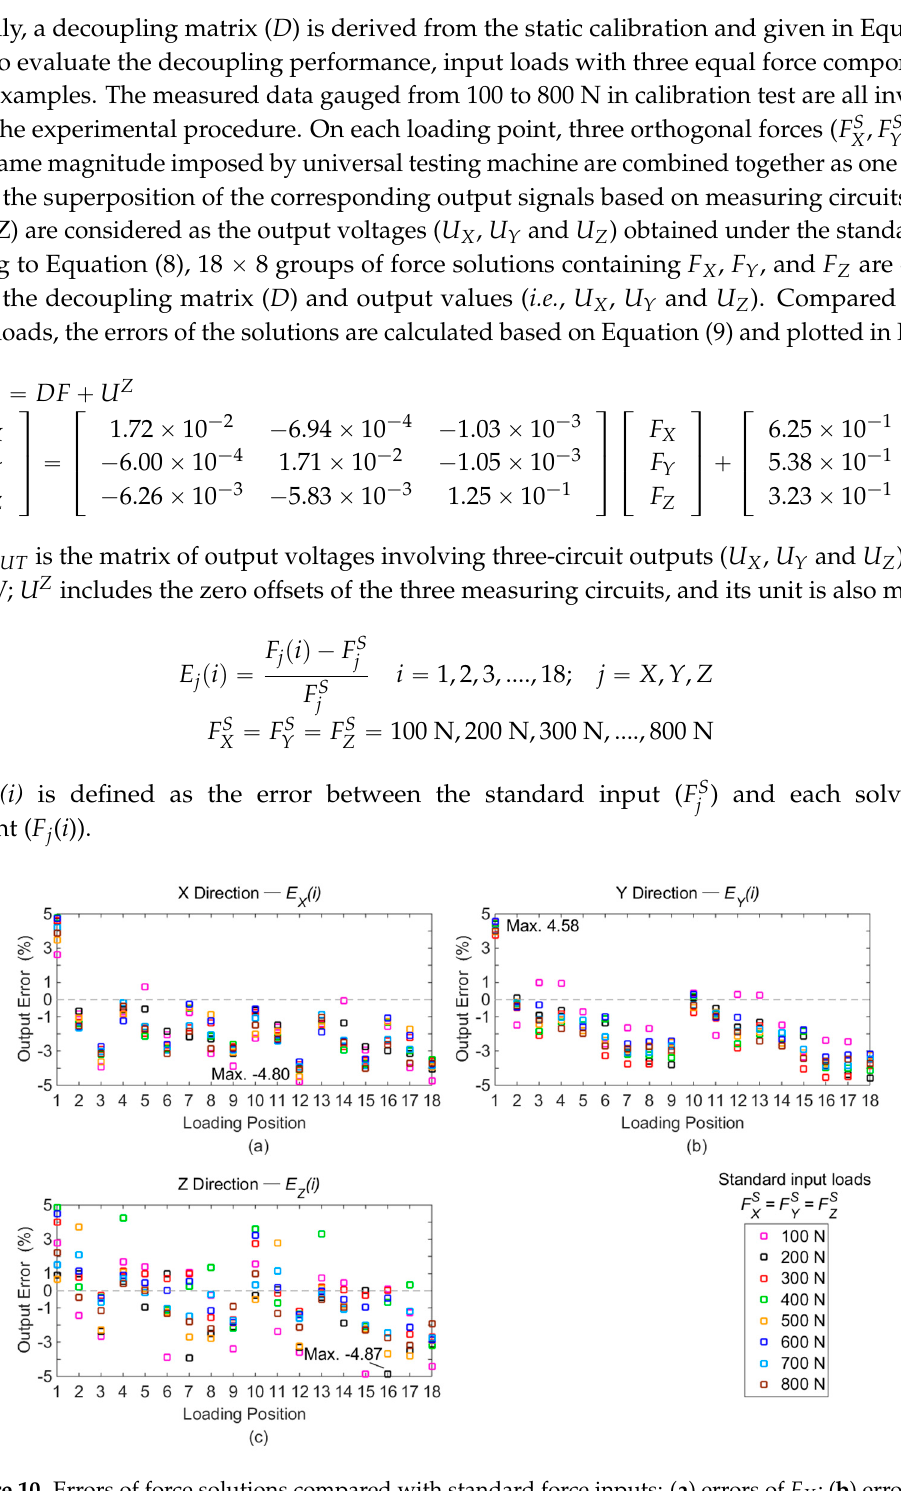
Figure 10. Errors of force solutions compared with standard force inputs: ( a ) errors of F X ; ( b ) errors of F Y ; ( c ) errors of F Z .